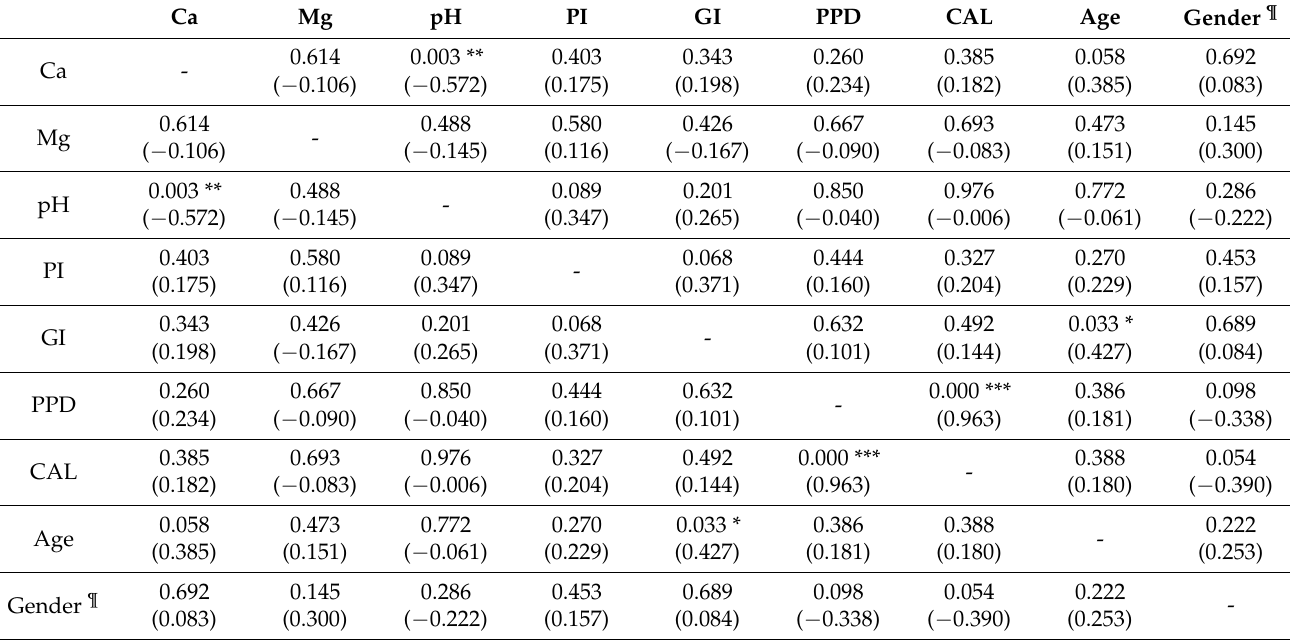
Table 5. Correlation analysis of parameters in Group